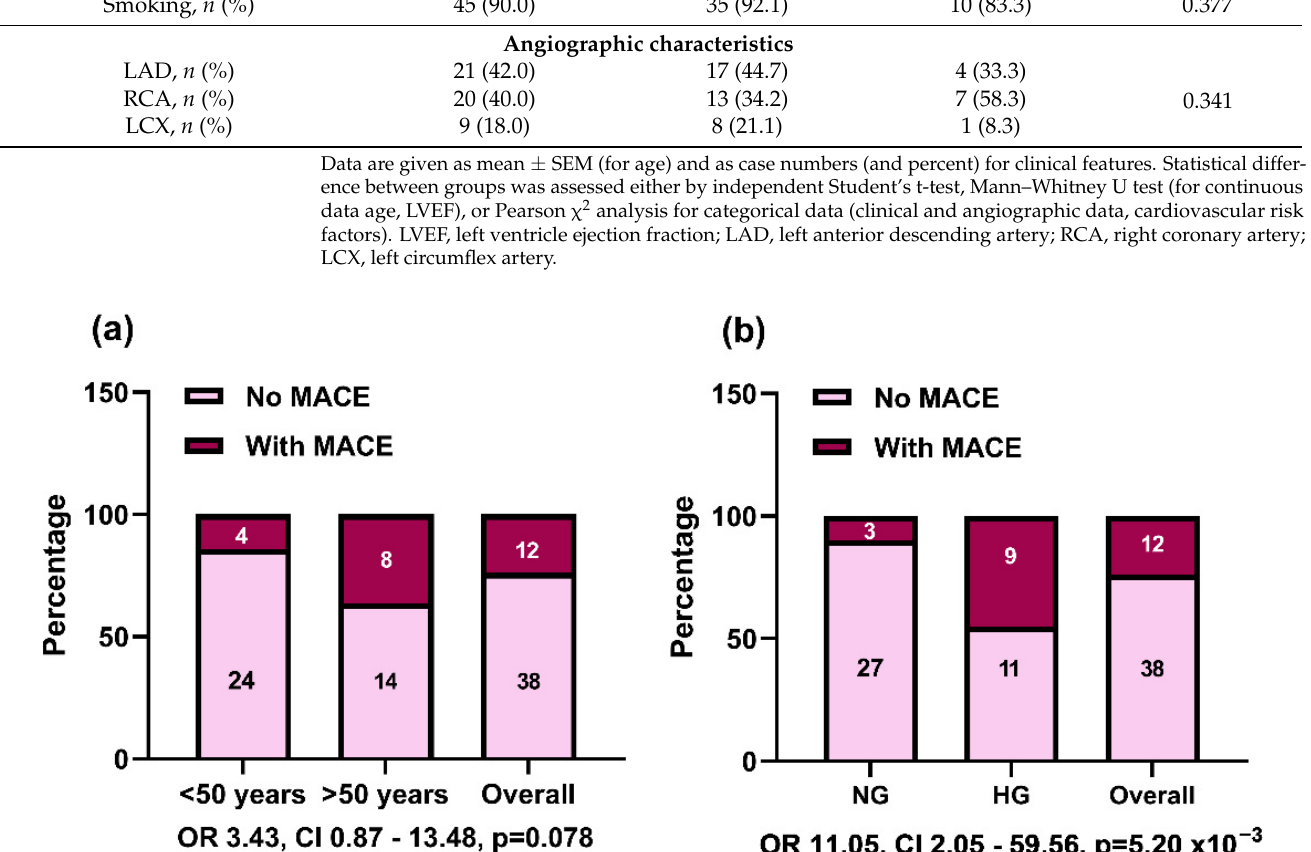
Figure 4. Distribution of major adverse cardiovascular events (MACE) occurrence at 6-month follow-up within age groups (below and over 50 years) ( a ) and hyperglycemic group (fasting glucose > 120 mg/dL during the hospital treatment) ( b ) in the ST-elevation myocardial infarction (STEMI) patients recruited for the study. The differences between group frequencies were analyzed by Pearson chi-square functions and Mantel–Haenszel common odds ratio (OR) estimates.